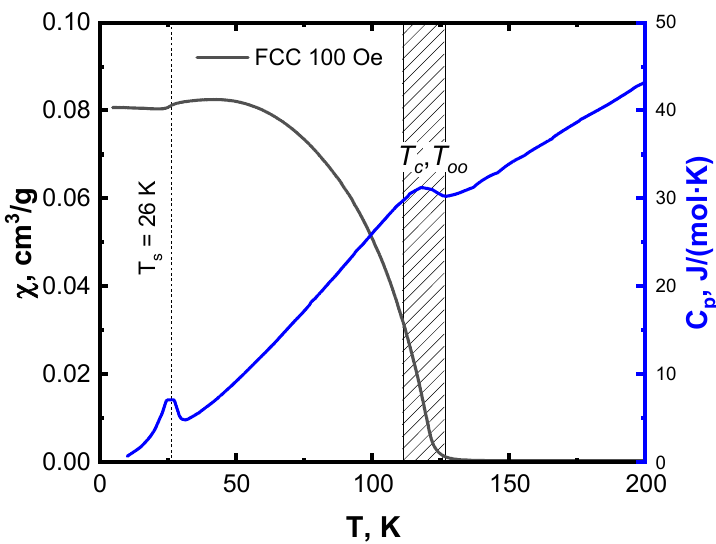
Figure 4. The temperature dependencies of the specific heat (blue curve) and the magnetic susceptibility recorded in the FCC regime (black curve) for Fe 2+ Cr 3+ 1.75 Fe 3+ 0.25 O 4 .